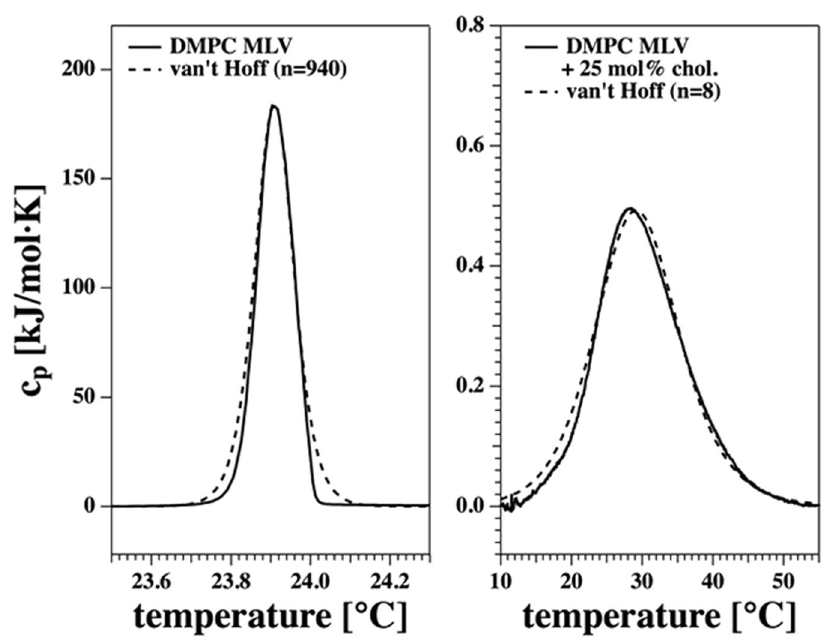
Figure 6. Heat capacity profiles from Fig. 1 for DMPC MLV (left) and DMPC + 25 mol% cholesterol (right). The dashed lines represent the calculated heat capacity profiles assuming a cooperative unit size of n = 940 for DMPC MLV and of n = 8 for the system in the presence of 25 mol%